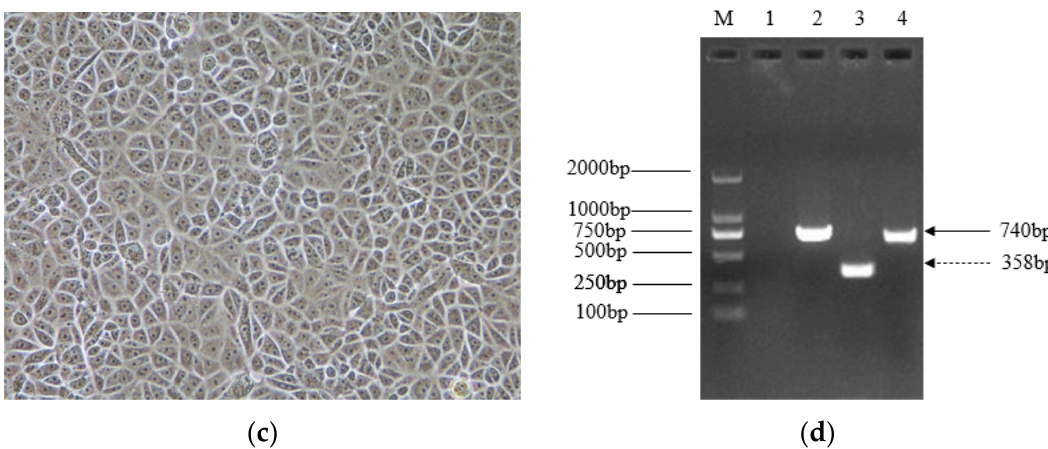
Figure 1. Virus isolation and purification of the PEDV strains with different ORF3 genotypes. CPE formation in Vero cells infected with the PEDV strains of ( a ) 17GXCZ-1ORF3d or ( b ) 17GXCZ- 1ORF3c showing rounded and clustered at 48 hpi (200×). ( c ) Vero cells control (200×). ( d ) Detection and amplification of the ORF3 gene in PEDV strains. M: DL 2000 marker; Lane 1: negative control; Lane 2: 17GXCZ-1ORF3c (~740 bp); Lane 3: 17GXCZ-1ORF3d with a large genomic deletion (~358 bp); Lane 4: CV777 strain (~740 bp). The solid arrows indicate the predicted products (740 bp) and the dashed arrows indicate the products of the PEDV variants with a large genomic deletion (~358 bp).